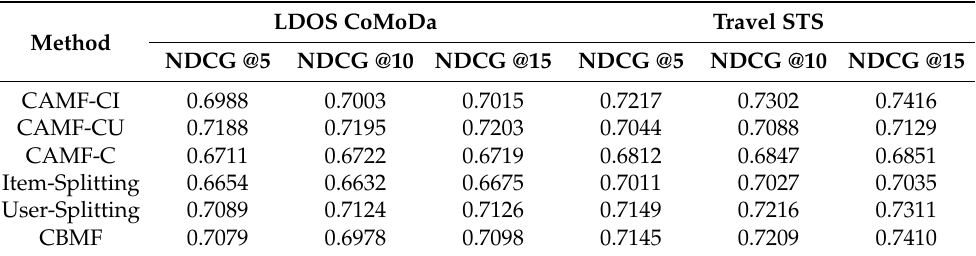
Figure 3. Results of the proposed approach on datasets DePaulMovie, LDOS-CoMoDa, and Travel- STS related to Normalized Discounted Cumulative Gain metric and the values N = 5,10,15. Table 13. Results on LDOS-CoMoDa and Travel-STS datasets related to Normalized Discounted Cumulative Gain metric and the values N =